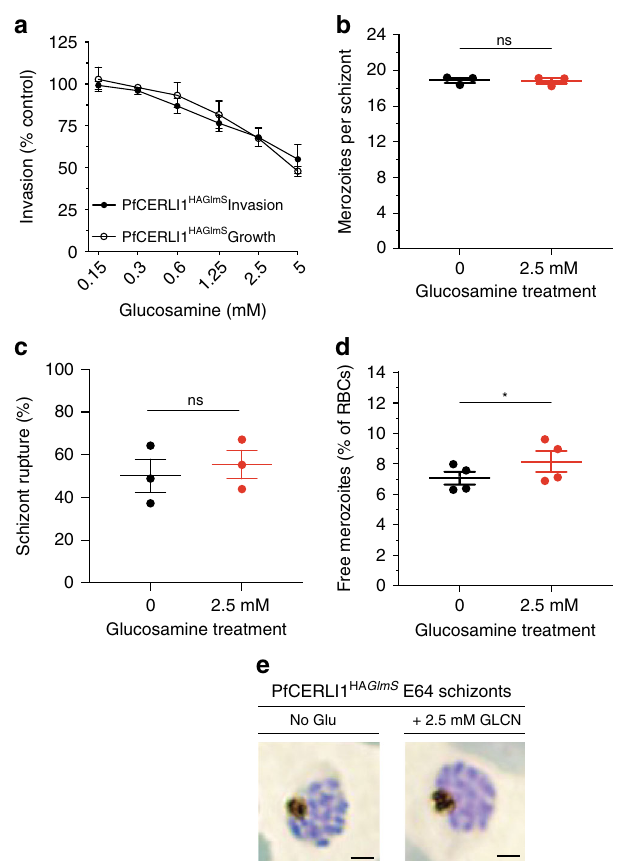
Fig. 2 PfCERLI1 knockdown does not inhibit merozoite development but does prevent merozoite invasion. a Flow cytometric detection of GFP- expressing PfCERLI1 HAGlmS/GFP ring stage parasites after merozoite invasion indicated a direct inhibition of merozoite invasion with protein knockdown (results presented as a % of media control, n = 4 biological replicates). PfCERLI1 HAGlmS Growth is replicated from Fig. 1g for direct comparison between growth and invasion inhibition. X -axis presented as log 2 scale for viewing purposes (Source data are provided as a source data fi le). b Mean number of fully segmented merozoites per schizont was determined by microscopy analysis of Giemsa-stained thin blood smears. Smears were blinded and counted with each data point representing the mean number of merozoites per schizont pooled from 20 schizonts, n = 3 biological replicates. c The percentage of schizont rupture that occurred over a 6-h window either with, or without, GLCN treatment ( n = 3 biological replicates), d The number of free merozoites after GLCN treatment was assessed using fl ow cytometry, with results presented as % of total erythrocytes ( n = 4 biological replicates). e Giemsa-stained PfCERLI1 HAGlmS schizonts, either GLCN treated or untreated, matured normally in the presence of E64. Scale bar = 2 µ m. All error bars = SEM. * p < 0.05, ns = p > 0.05 by unpaired t